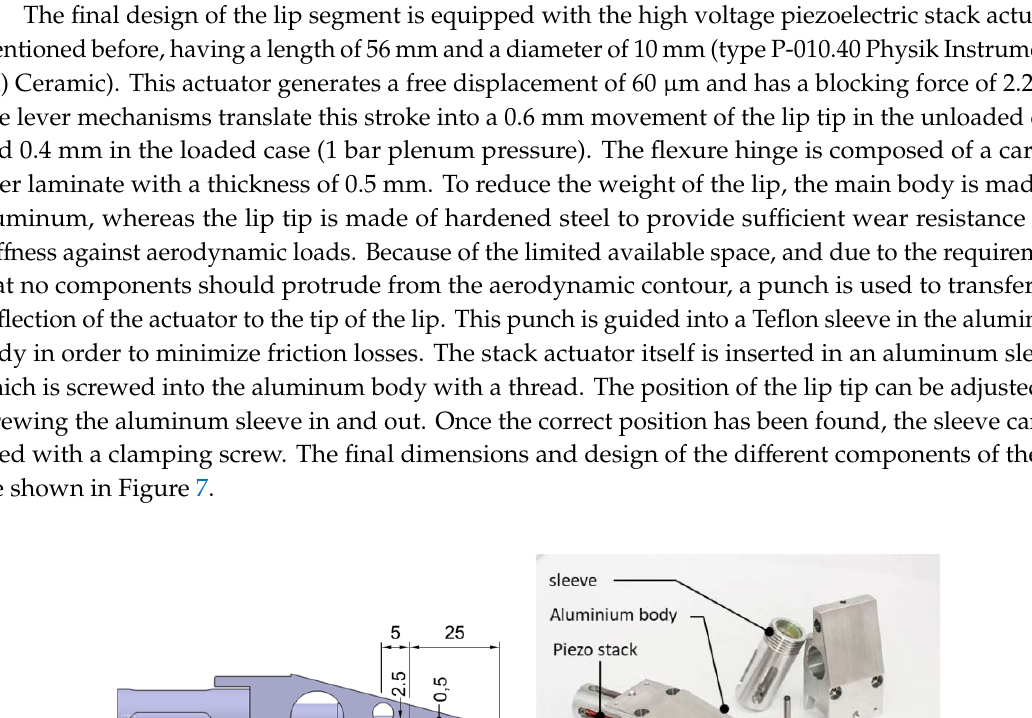
Figure 6. Simplified model of the actuated lip.